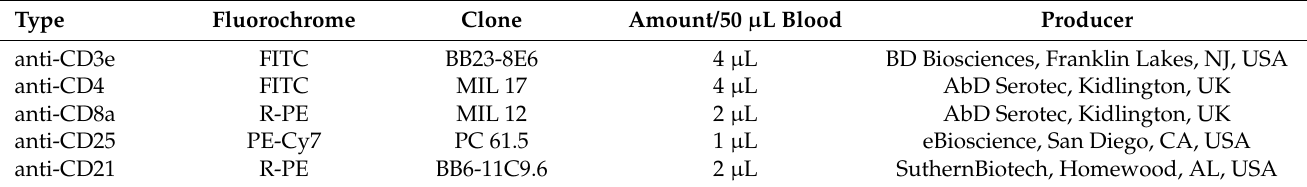
Table 2. Specification and amounts of used mouse anti-porcine monoclonal